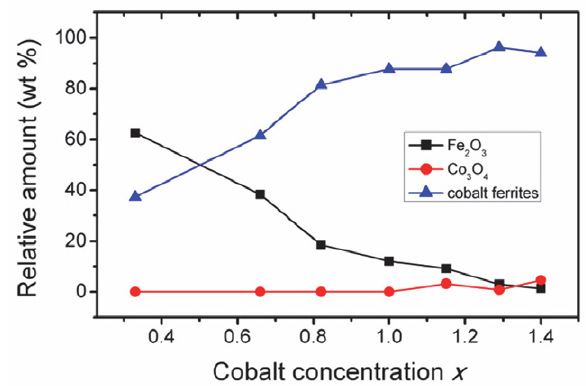
Figure 3. Mass percentage of individual phases in samples.